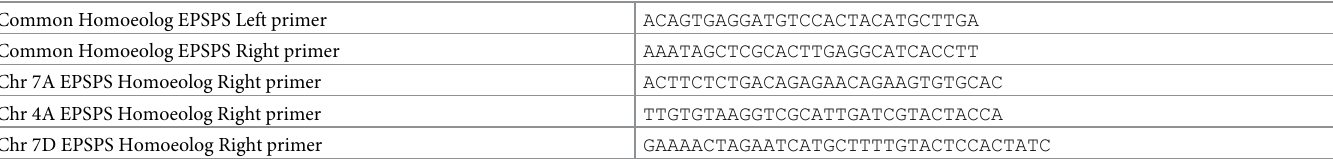
Table 1. Primer pairs used for gene amplification, TILLING and genotyping.